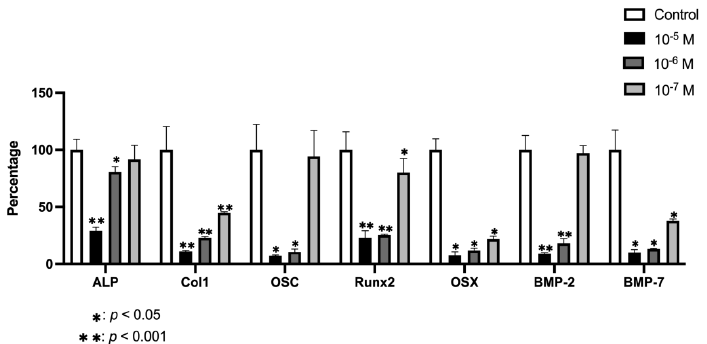
Figure 6. Expression of osteoblast genes (ALP, COL-1, OSC, RUNX2, OSX, BMP-2, and BMP-7) treated for 24 h with BPA at doses of 10 −5 , 10 −6 , or 10 −7 M. The data are expressed as the mean of expression percentage with respect to control group ± standard deviation. * Significant differences p < 0.05, ** p < 0.001.